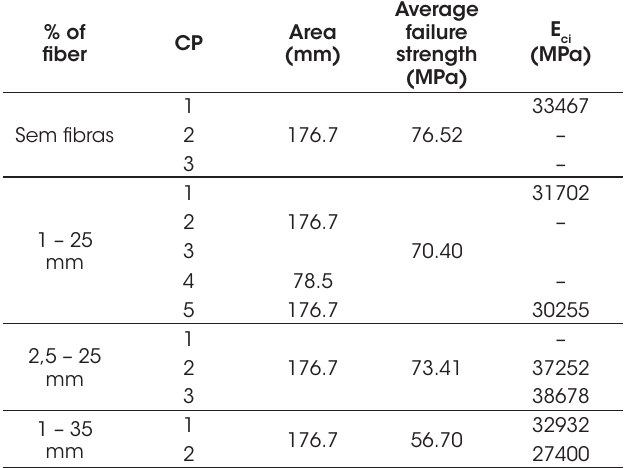
Concrete compression tests results